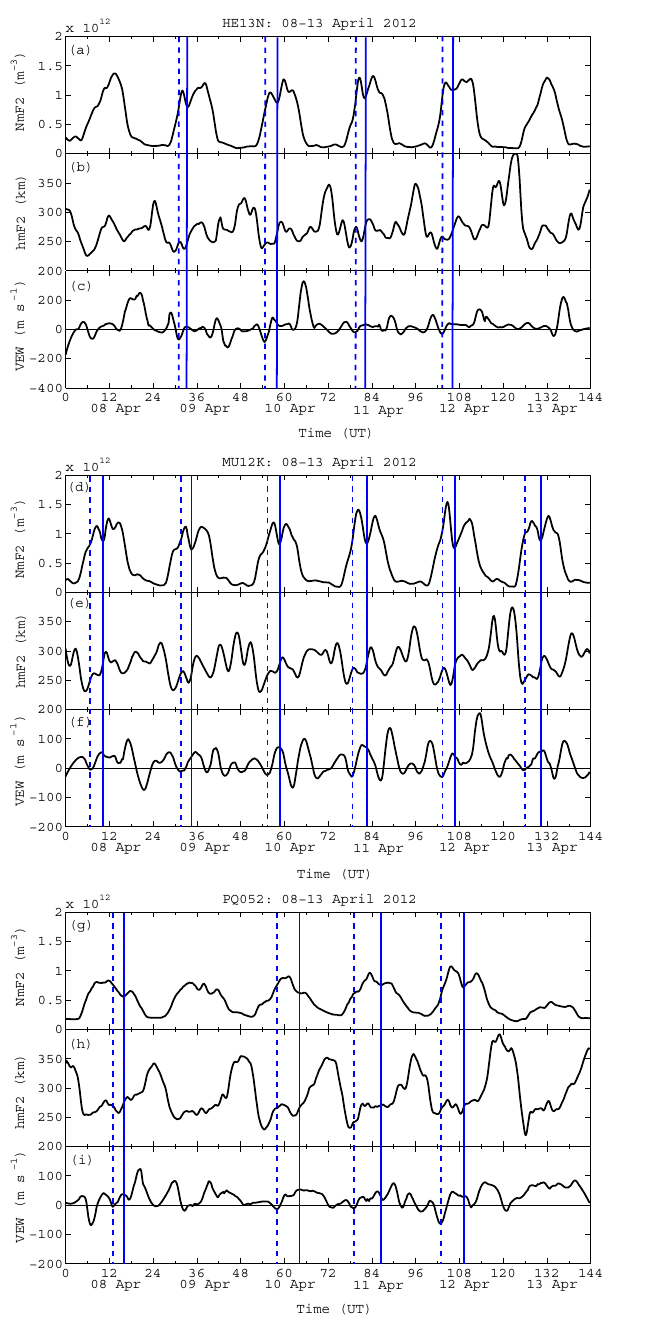
Figure 5. Nm F2 measurements ( a , d and g ) from Hermanus, Madimbo and Pruhonice ionosonde stations observed on 8– 13 April 2012, showing twin-peak structures, as well as correspond- ing hm F2 measurements in kilometres ( b , e and h ) and vertical com- ponent of equivalent winds in metres per second ( c , f and i ). Vertical blue lines mark depletions in Nm F2, and vertical dash lines indicate downward wind prior to Nm F2 depletion.